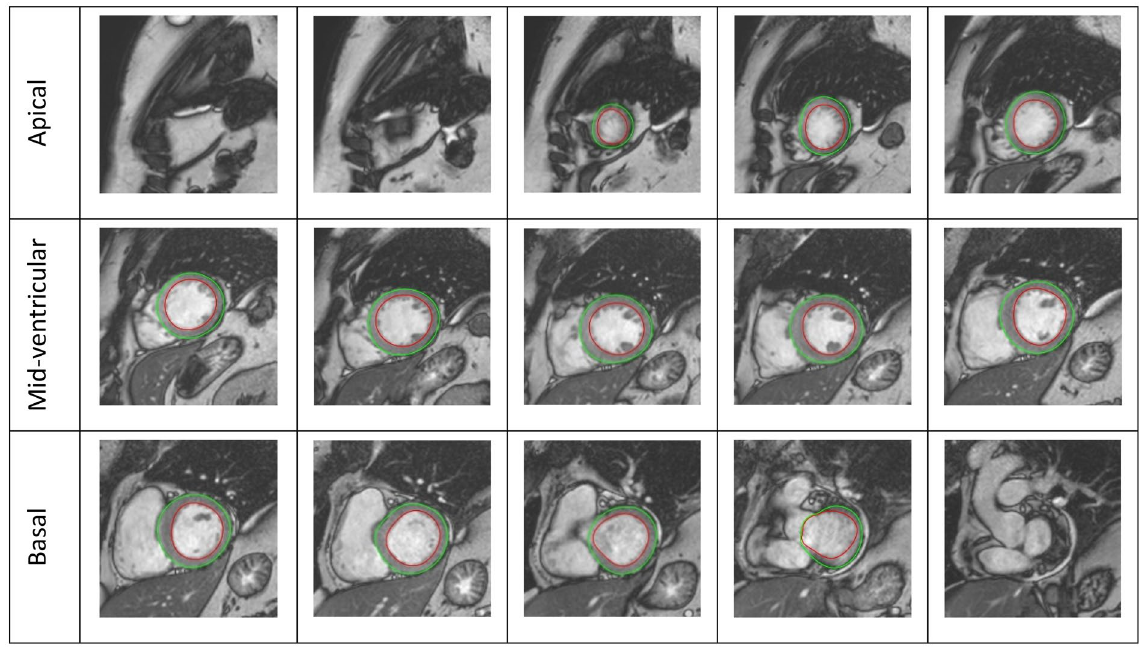
Figure 3. SAX image slices with automated contouring starting from the apical view and ending with the outflow tract of the LV. LV, left ventricle; SAX, short